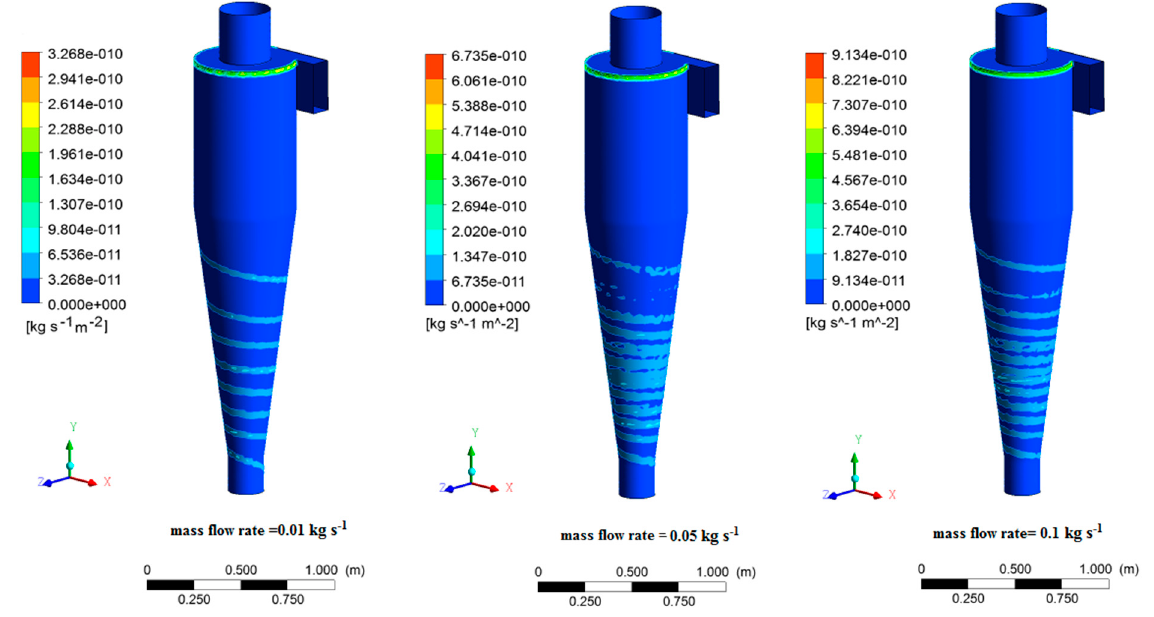
Figure 14. Erosion contours in various mass flow rates.